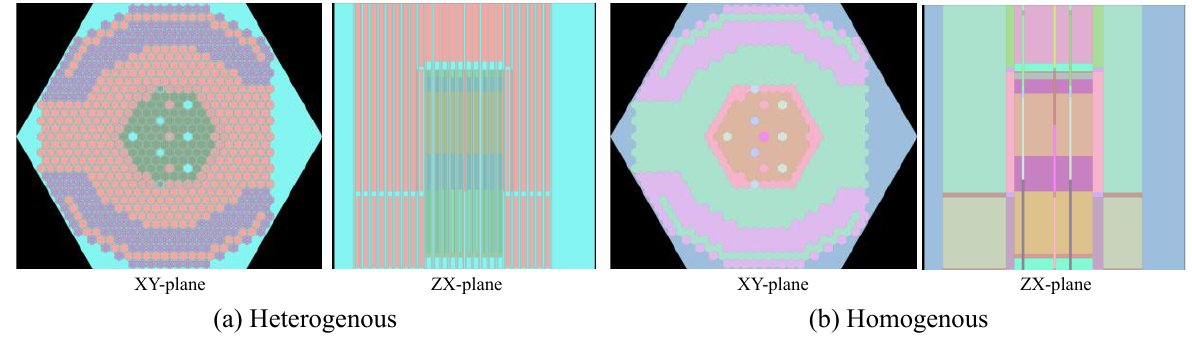
Figure 2. SERPENT-2 Cross-sectional View of CEFR heterogeneous (left) and homogenous (right)Core